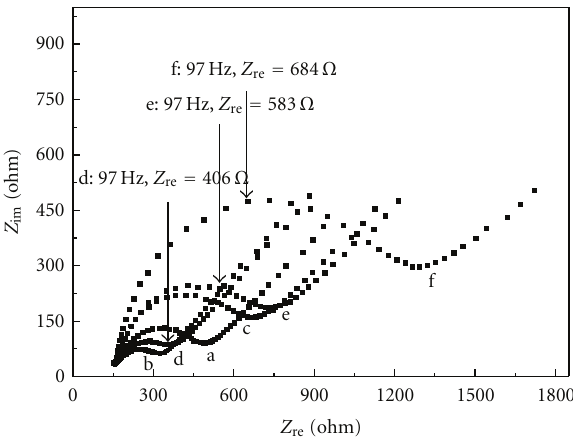
Figure 1: Nyquist plots obtained at di ff erent modified electrode. (a) Bare gold electrode, (b) AuNPs, (c) MAA/AuNPs, (d) activat- ed MAA/AuNPs, (e) ss-DNA/MAA/AuNPs, and (f) ds-DNA/MAA/ AuNPs modified electrodes. The supporting electrolyte was 0.1M KCl solution containing 5.0mM K 4 Fe(CN) 6 /K 3 Fe(CN) 6